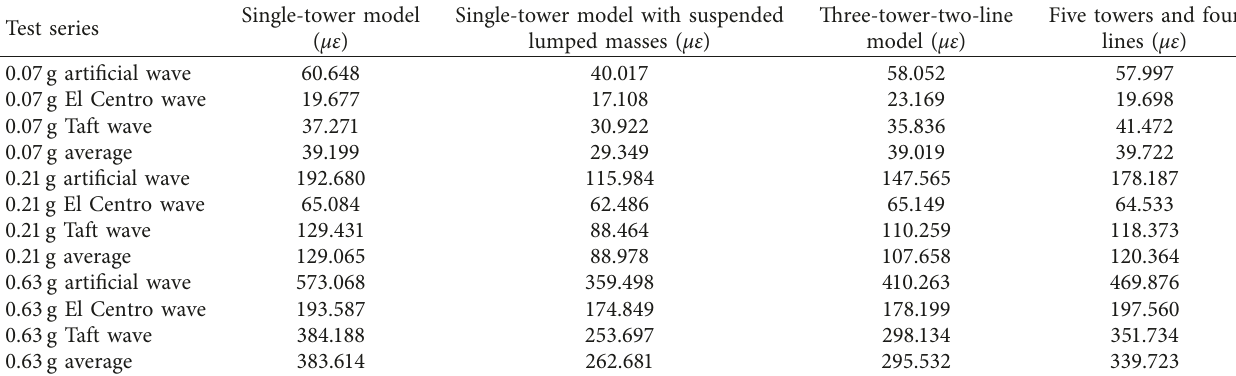
Table 10: Transverse peak strain responses of the middle towers of the four